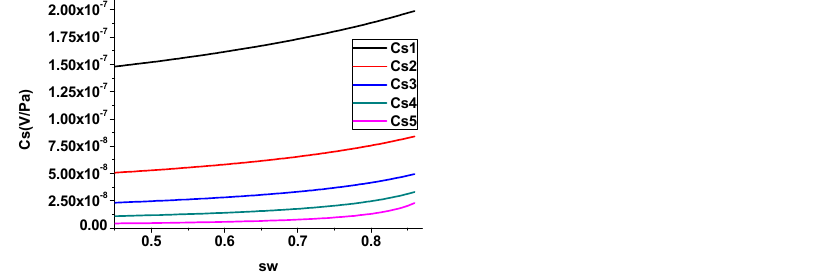
Figure 11. Influence of salinity on streaming potential coupling coefficient (slug flow). Figure 12 studies the effect of pore fluid viscosity on the streaming potential coupling coefficient of the capillary under the condition of slug flow. The viscosity is taken as 0.001 Pa s ⋅ , 0.002 Pa s ⋅ , 0.003 Pa s ⋅ , 0.004 Pa s ⋅ , and 0.005 Pa s ⋅ , respectively. It can be seen from the figure that as the viscosity increases, the coupling coefficient gradually decreases. With the increase in viscosity, the seepage velocity of pore fluid will decrease, and the gradient of pore fluid seepage velocity will decrease, so the streaming current will de- crease, resulting in the decrease in the coupling coefficient. 0.5 0.6 sw Cs1 Cs2 Cs3 Cs4 Cs5 Figure 12. Influence of viscosity on streaming potential coupling coefficient (slug flow). It can be seen from Figures 3 and 8 that, as the saturation decreases, the streaming potential coupling coefficient of the capillary first increases and then decreases. Figure 13 is a comparison between the simulation in this work and some experimental results in Ref. [14]. The black curve is the simulation result of this paper, and the blue points are part of the experimental result from Ref. [14]. The change trends with saturation are the same, which can prove the correctness of this work. 0.4